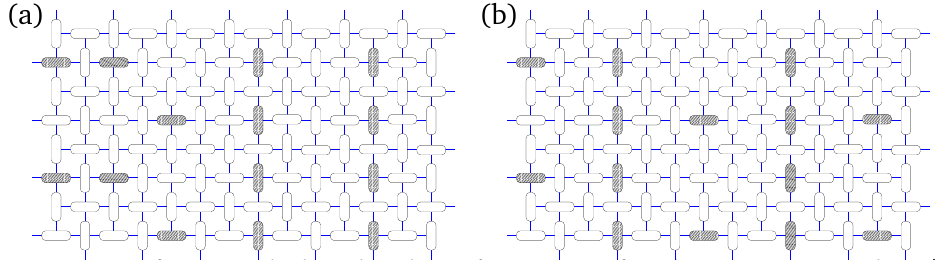
Figure 17: A few typical (disordered) configurations of triplons pertinent to the 1 / 8- plateau phase.